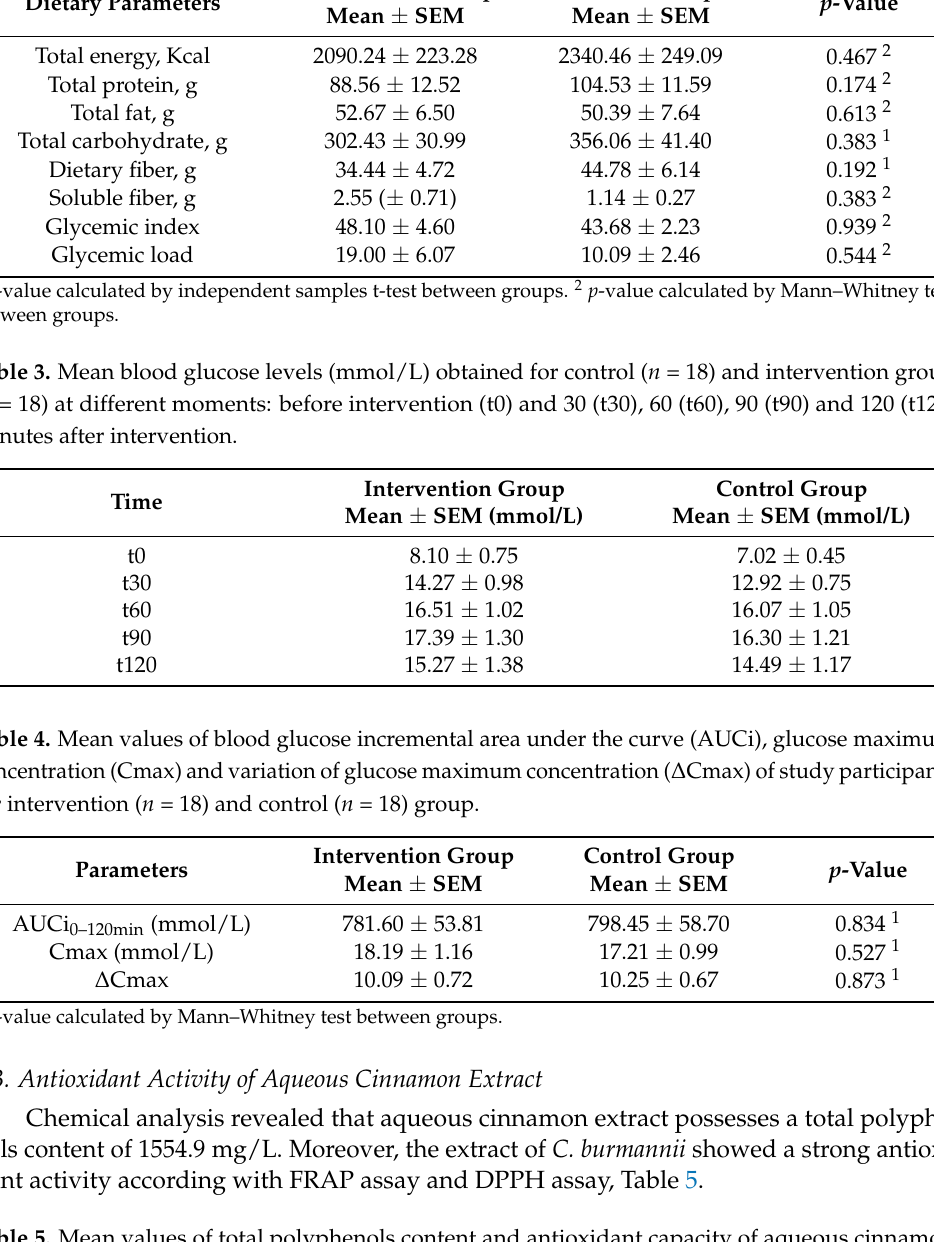
Table 5. Mean values of total polyphenols content and antioxidant capacity of aqueous cinnamon extract. The results are expressed in mean ±